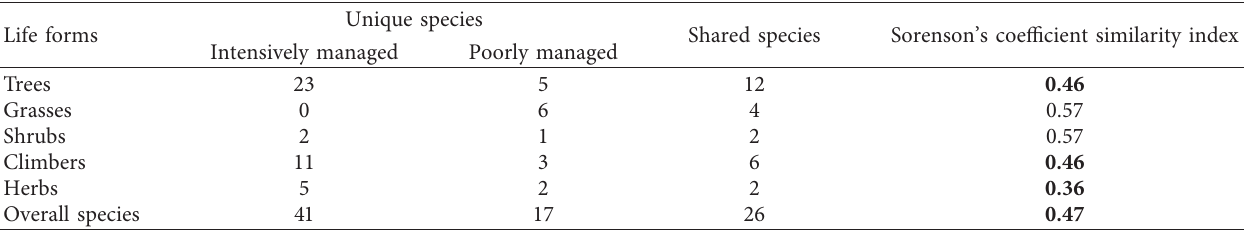
Table 3: Overall understorey species similarity in life forms in the intensively and poorly managed Tectona grandis plantation. Life forms